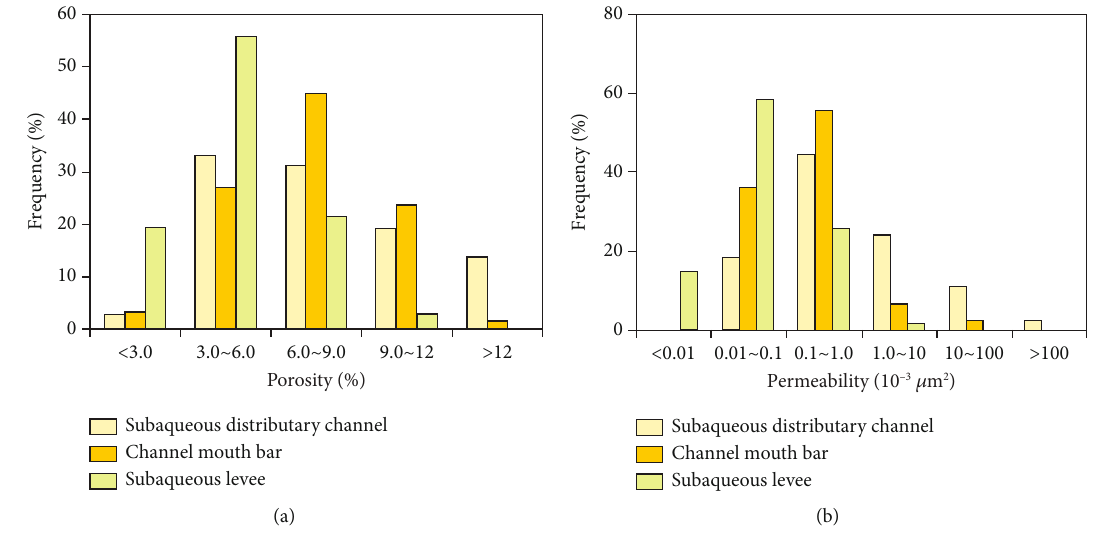
Figure 6: Distribution of porosity and permeability of di ff erent sedimentary microfacies.